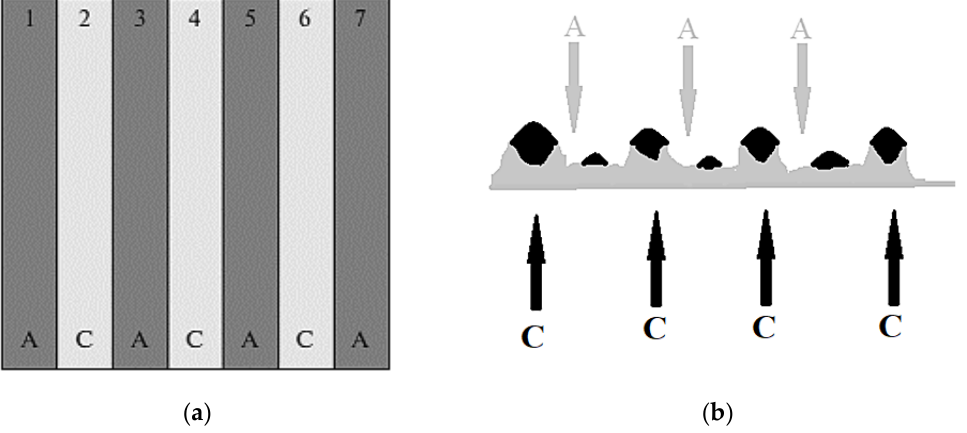
Figure 7. Morphological features of the technology of mosaic membranes “from anion to cation exchanger“. ( a ) Mosaic membranes by the method of polycondensation filling. ( b ) Formation of a cationite matrix. A = anion-exchange, C = cation-exchange.